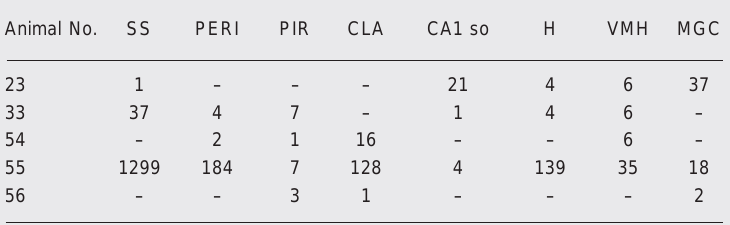
Table 3. Number of silver-stained cells at selected septotemporal levels in SRS + SE animals. Animal